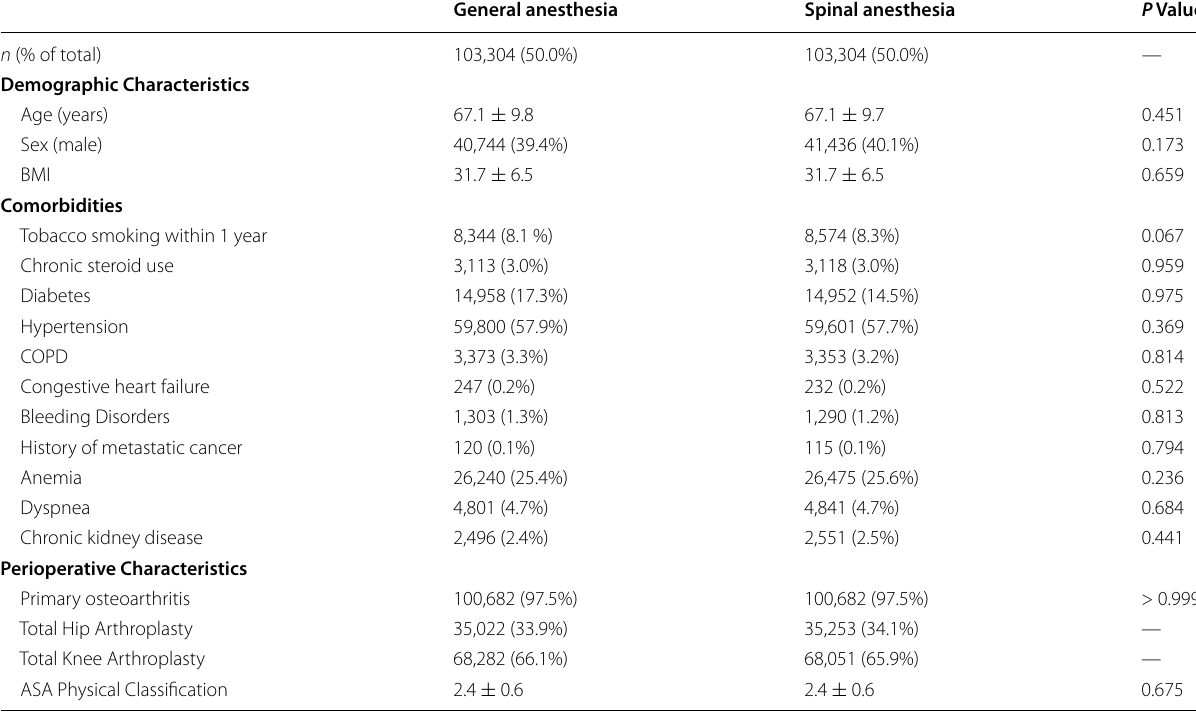
Table 1 Baseline characteristics of the study